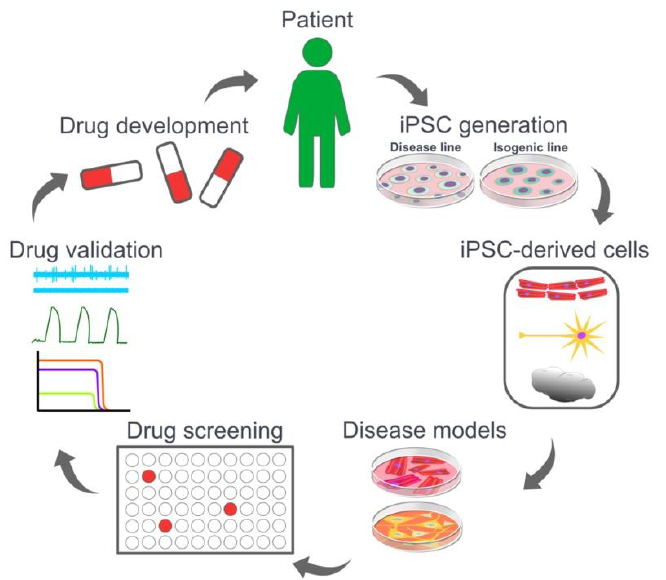
Figure 1. Disease modeling and drug screening using patient-specific induced pluripotent stem cells.